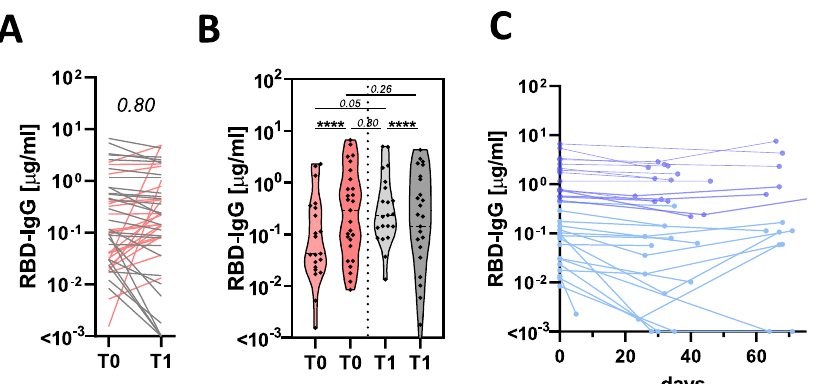
Fig. 2 SARS-CoV-2 titer heterogeneity over time. A The line graph shows the trajectory of the humoral immune response after the fi rst antibody-positive timepoint (red lines show individuals that experience an increase in their antibody titers and gray shows individuals that exhibit stable or low-level waning) ( n = 48). B The violin plots show the T0 and T1 RBD-speci fi c IgG titers across individuals that experience an increase (reds) or experience stable or decreasing (grays). C The line plot shows the overall decay pro fi les once all samples were aligned based on study maximum observed titer (highest titer per individual observed in this study) ( n = 32). The shades of blue show the individuals with the higher study maximum titers in the deep blue or lower observed titers in the light blue. Statistical differences between T0 and T1 within a group in ( A ) and ( B ) were assessed with a paired Wilcoxon-test and differences across groups and timepoints were assessed with the Kruskal – Wallis test followed by a post hoc Dunn ’ s correction for multiple testing. **** p < 0.0001 or exact p -values for not signi fi cant comparisons. Source data are provided as a Source Data fi le.